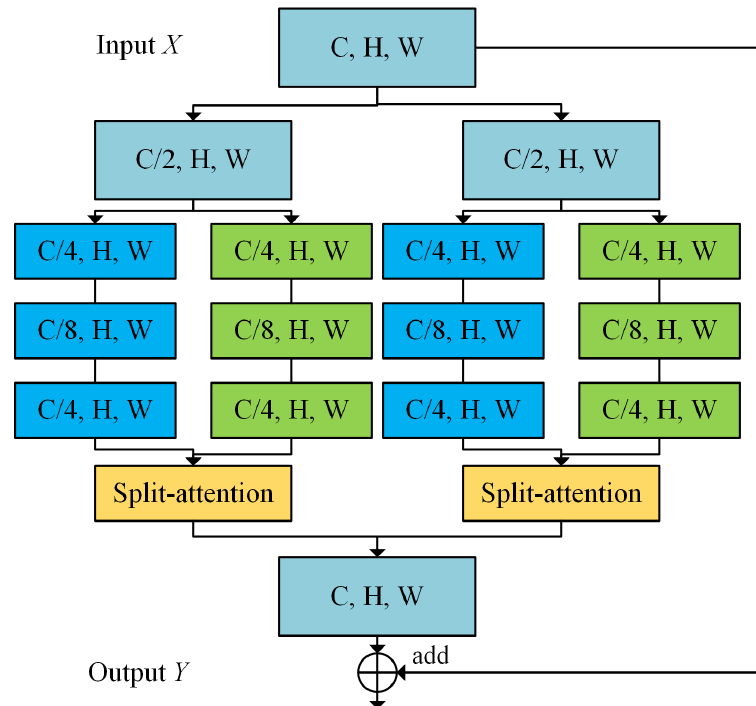
Figure 2. ResNeSt block (only two branches are shown for